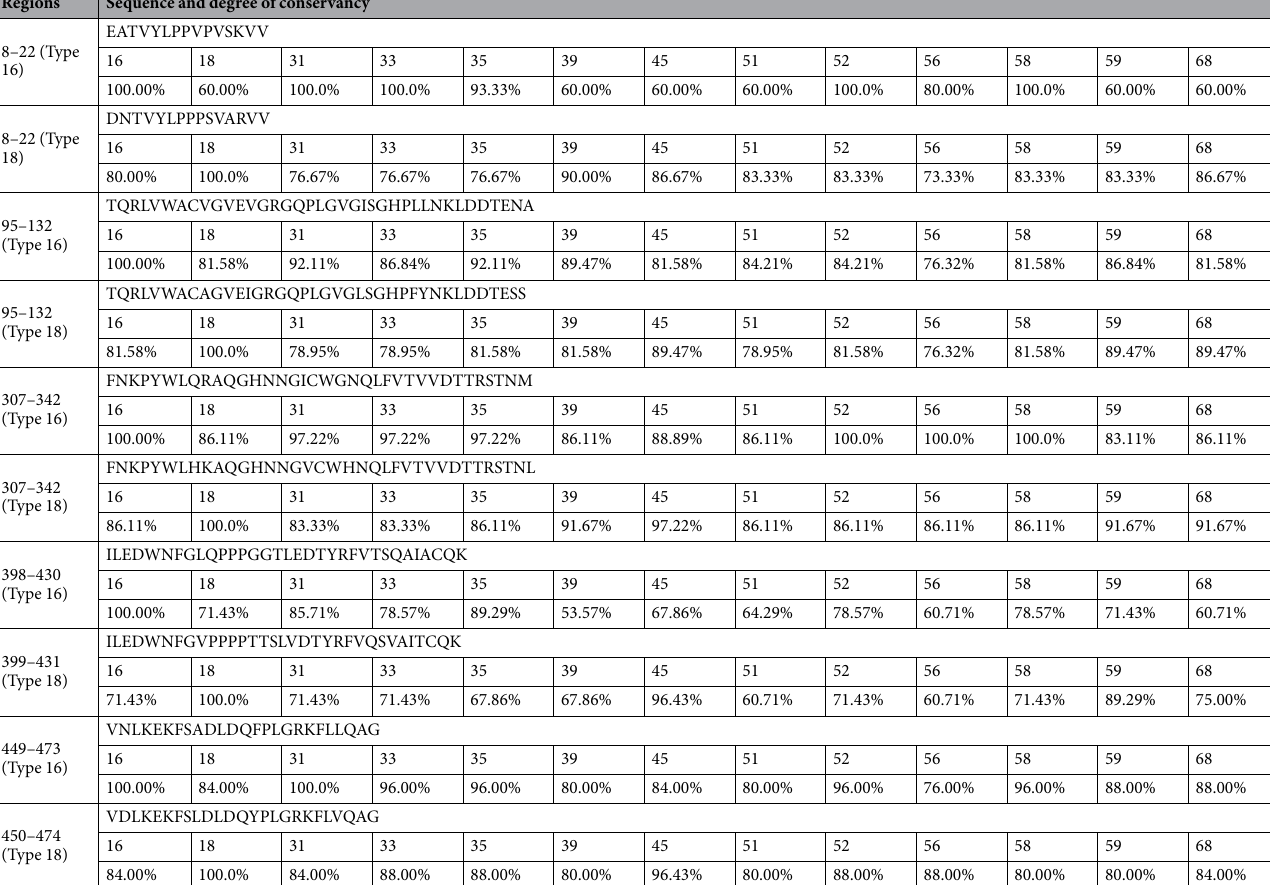
Table 1. Conservancy analysis of high-risk HPV L1